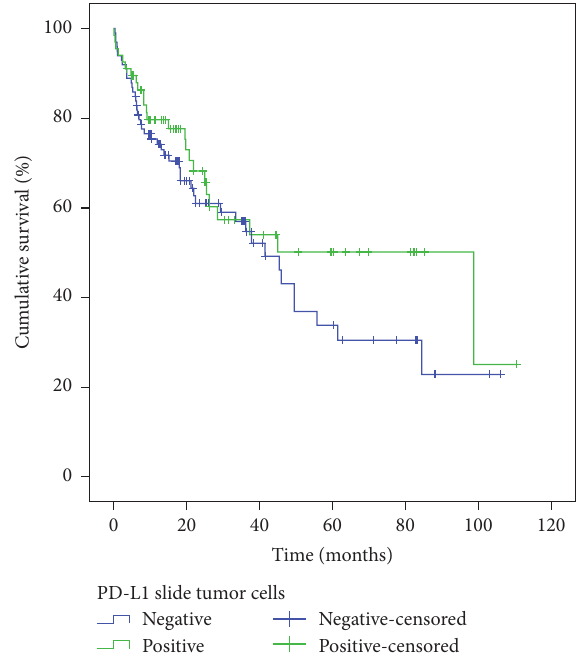
Figure 4: Overall survival according to PD-L1 expression in tumor cells. x -axis: time after diagnosis in months. y -axis: percentage of patients alive (total of 177 patients).